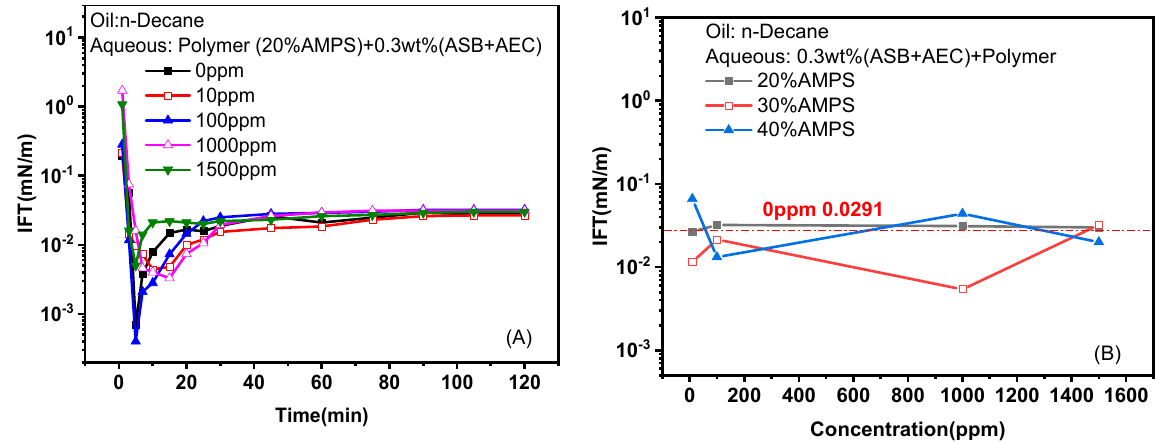
Figure 4. Effect of polymer concentration on dynamic ( A ) and equilibrium ( B ) IFTs between 0.3 wt% ASB@AEC solution and n-decane.